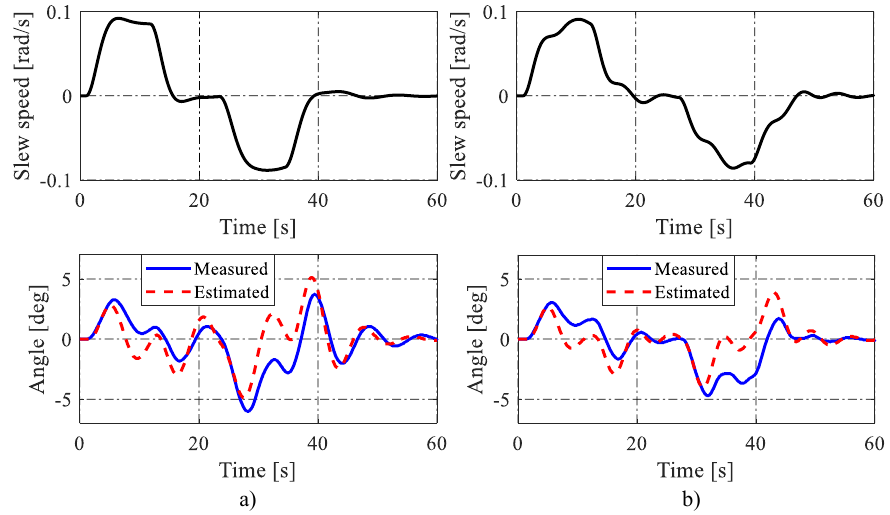
Figure 7. Comparison of control performance ( a ) without swing angle control and ( b ) with swing angle